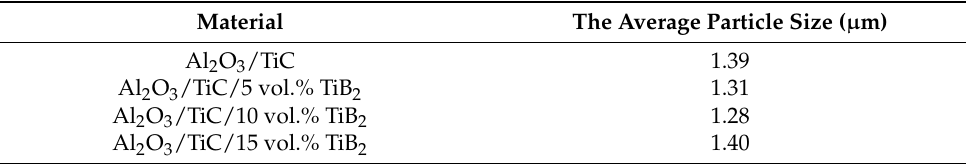
Table 3. Average particle size of different components of the